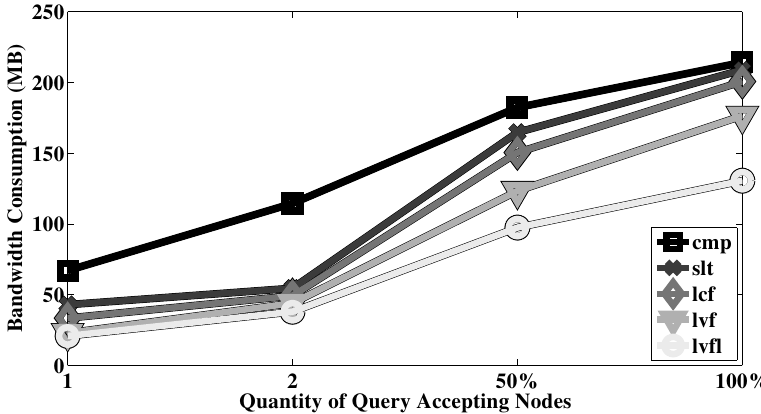
Figure 6. Different query issuance patterns (i.e., varying number of nodes to which a fixed number of queries are issued to.